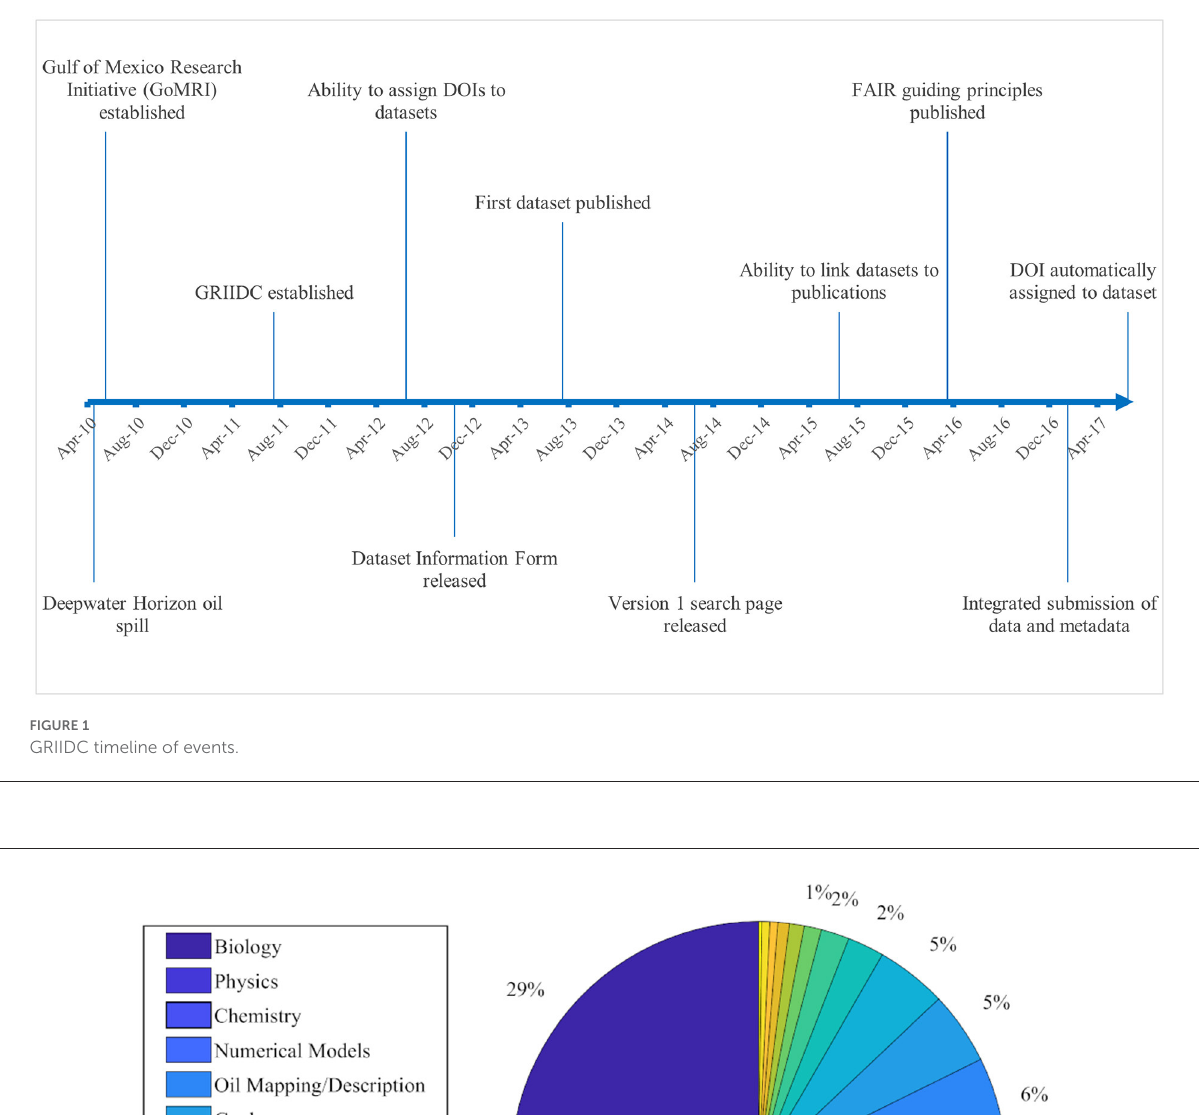
FIGURE2 Distribution by discipline of the 3,086 GoMRI-funded datasets. Imagery and model datasets typically have a second classification indicating subject matter. Classes not labeled with a percentage comprise < 1% of the total GoMRI-funded